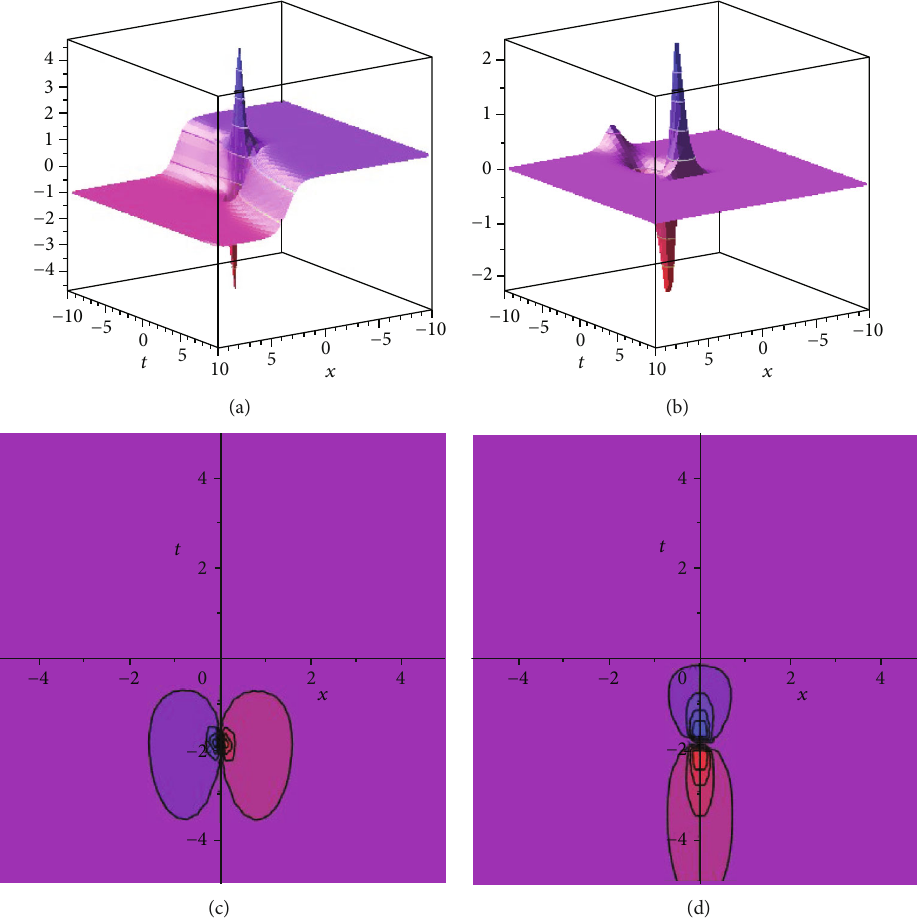
ð x , t Þ : (a) real three-dimensional shape, (b) complex three-dimensional shape, (c) 1